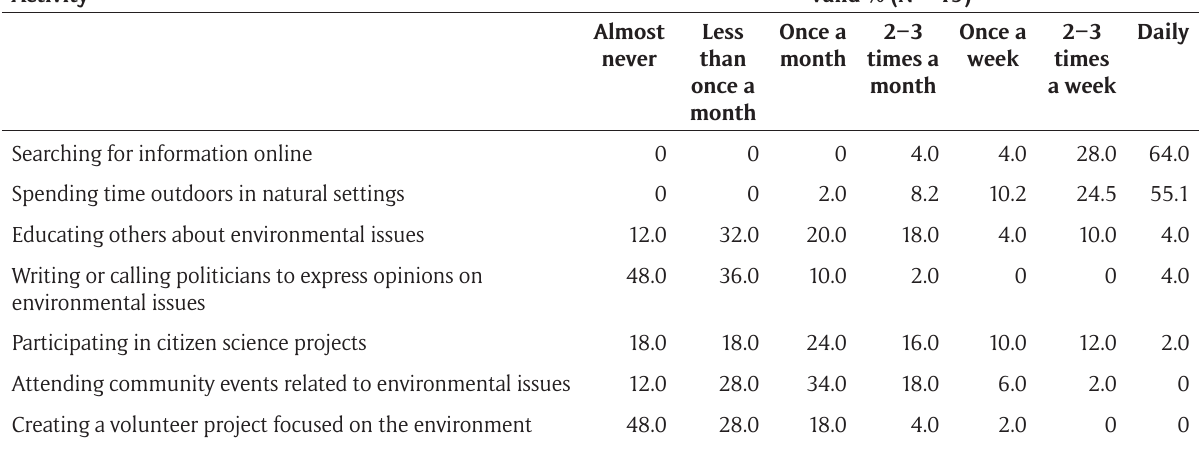
Table 2: Frequency of volunteer participation in various project-associated activities. Activity